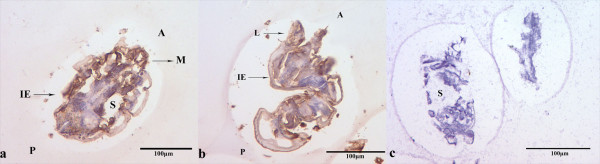
Immunolocalization of tropomyosin in sections of S. scabiei.  (A, B) Staining with anti-tropomyosin as primary antibody. (C) Control (pre-immune sera). The EnVision TM + System-HRP(DAB) (DAKO) was used, according to the manufacturer’s instructions for detection of the rabbit antibodies. M, mouthparts; L, legs; S, stomach blocks; IE, the integument of epidermis; A, anterior end of mite; P, posterior end of mite.